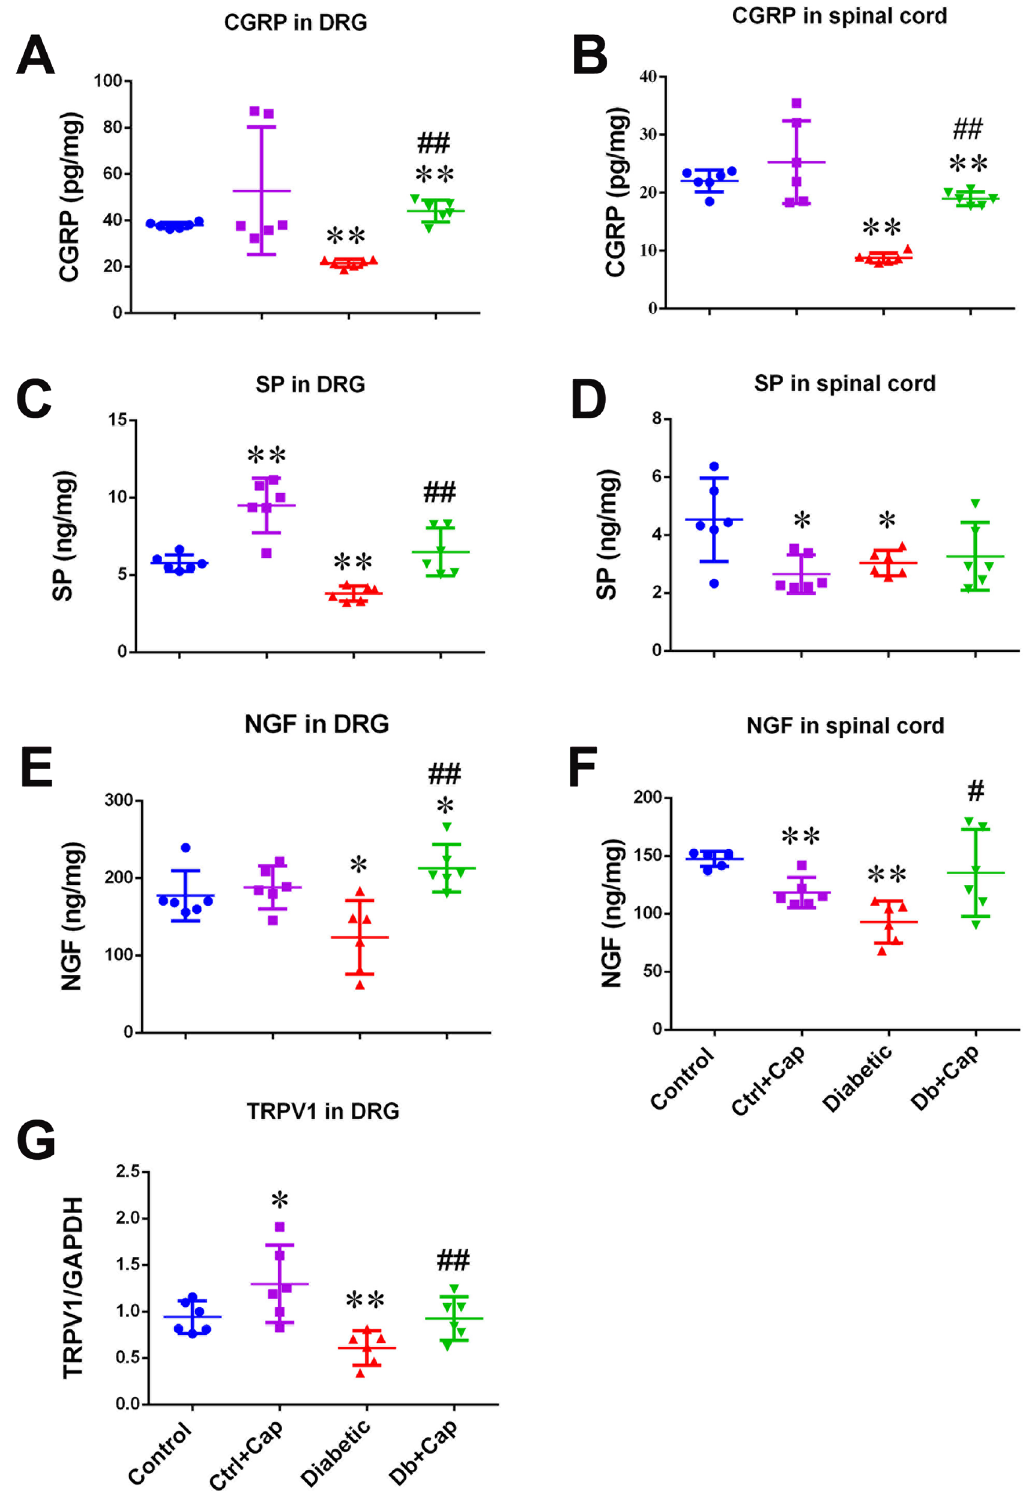
Figure 3. Preservation of CGRP, SP, NGF and TRPV1 in the DRGs and the spinal cord. Significant preservation of CGRP, SP, NGF and TRPV1 in the DRGs ( A , C , E , G , respectively) and CGRP and NGF in the spinal cord ( B , D , F , respectively), at the 5th lumber segment, was detected in the capsaicin treated diabetic animals. In the spinal cord, only CGRP was preserved in the non-diabetic animals treated with capsaicin. Control non-diabetic control group, Ctrl + Cap non-diabetic animals treated with capsaicin, Diabetic diabetic group, Db + Cap diabetic animals treated with capsaicin. * p < 0.05, compared to the control; ** p < 0.01, compared to the control; # p < 0.05, compared to diabetic; ## p < 0.01, compared to